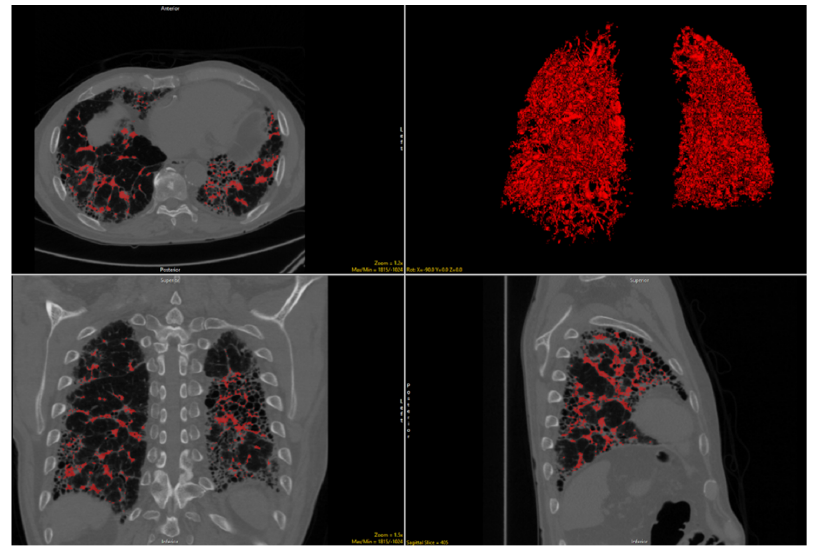
Figure 1. Delineation of volume-related structures on noncontract chest CT images and 3D recon- struction in a patient with idiopathic pulmonary